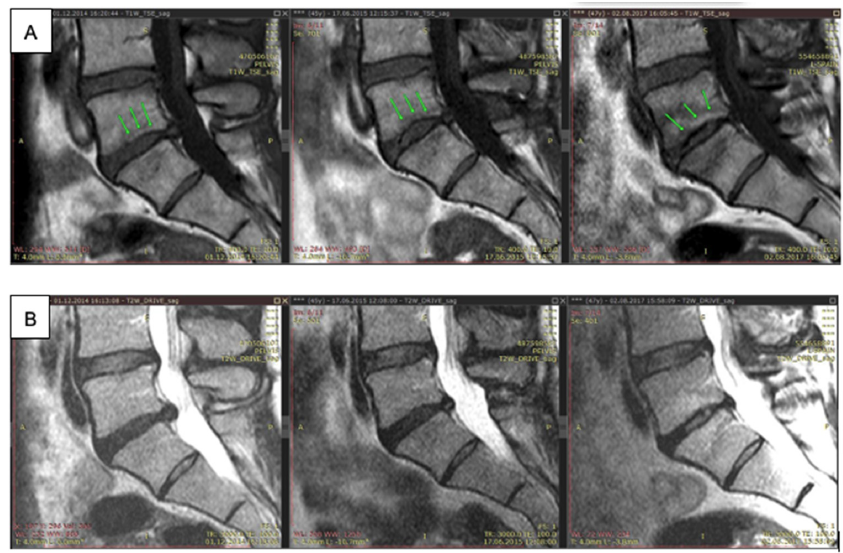
Figure 10. Combination of LRD and microscopic discectomy for a female, 44 y.o., with L5S1 disc herniation: ( A ) MRI T1 WI. Preoperative ( left picture ), 6.5 months after surgery ( center picture ), 3 years after surgery ( right picture ). Change of the signal intensity at the adjacent to the disc bone (arrows) manifests an increase in disc metabolism; ( B ) MRI T2 WI. Disc degeneration after Pfirrmann [74]: Grade 4—preoperative ( left picture ), Grade 3–6.5 months after surgery ( center picture ), Grade 2—in 3 years after surgery ( right picture ).